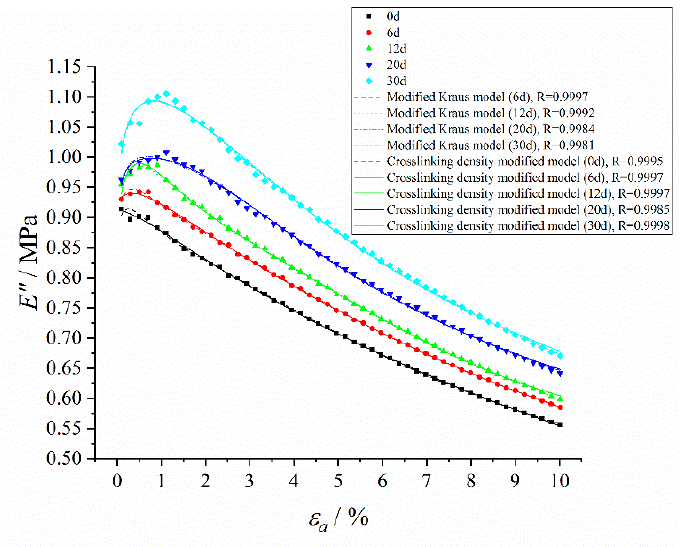
Figure 12. The loss modulus fitting curves of the crosslinking density modified model and modified